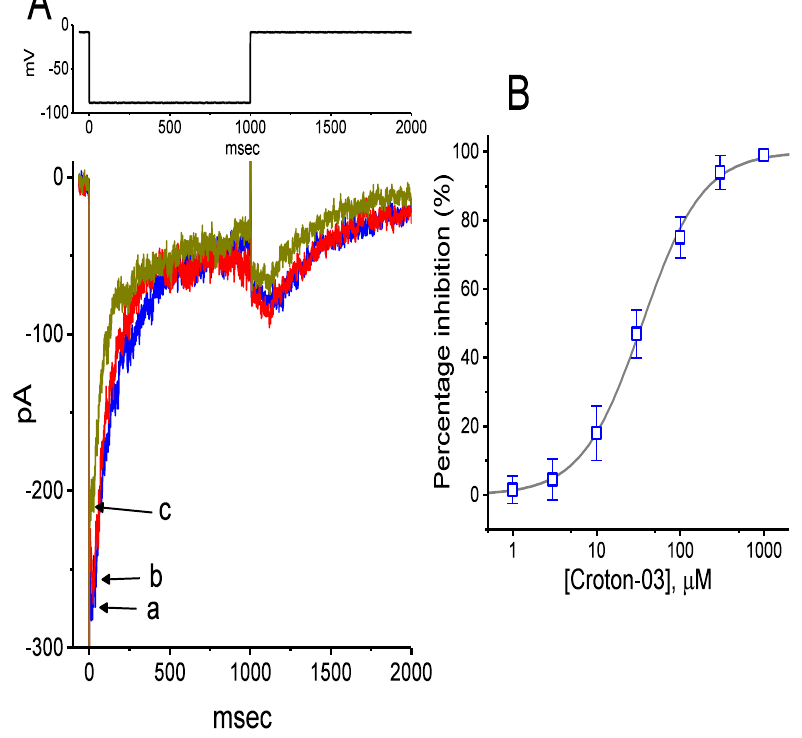
Figure 5. E ff ect of croton-03 on erg -mediated K + current ( I K(erg) ) in GH 3 cells. In these experiments, cells were bathed in Ca 2 + -free, high-K + solution, and the electrode was filled with K + -containing solution. ( A ) Representative I K(erg) traces obtained in the control (a) and during the exposure to 3 µ M croton-03 (b) or 10 µ M croton-03 (c). The upper part indicates the voltage protocol applied. ( B ) Concentration-dependent inhibition by croton-03 of I K(erg) amplitude (mean ± SEM; n = 7–8 for each point). Each cell was hyperpolarized from − 10 to − 90 mV and current amplitudes obtained during the exposure to di ff erent croton-03 concentrations were measured at the beginning of each hyperpolarizing step. The smooth curve was least-squares fitted by the Hill equation (see text for details), and the IC 50 value was constructed and then estimated to be 35.3 µ M.